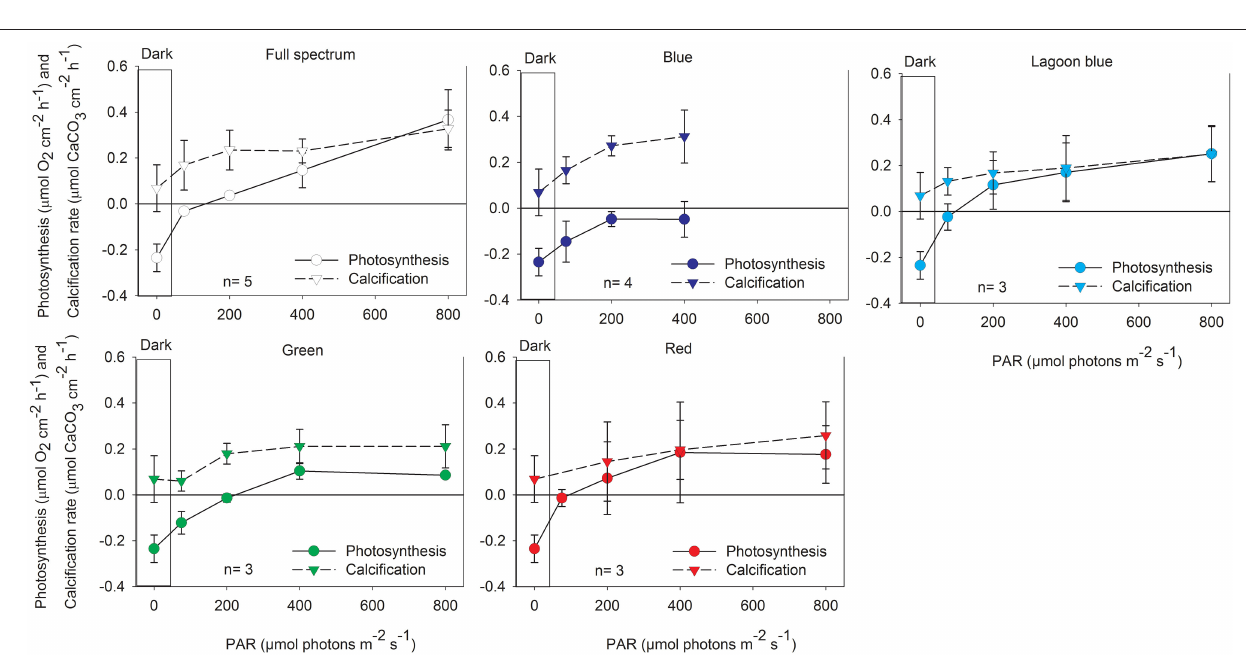
photons m − 2 s − 1 ). This was reflected by a vast increase in photosynthetic compensation and saturation intensity compared to full spectrum. While photosynthesis of P. lutea was also